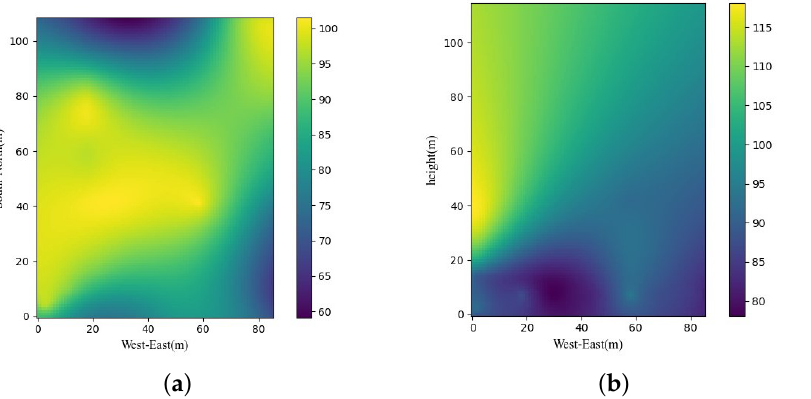
Figure 10. PM2.5 data interpolation results. ( a ) Horizontal interpolation at 50 m height; ( b ) vertical interpolation at latitude 39.240467, longitude from 117.053912 to